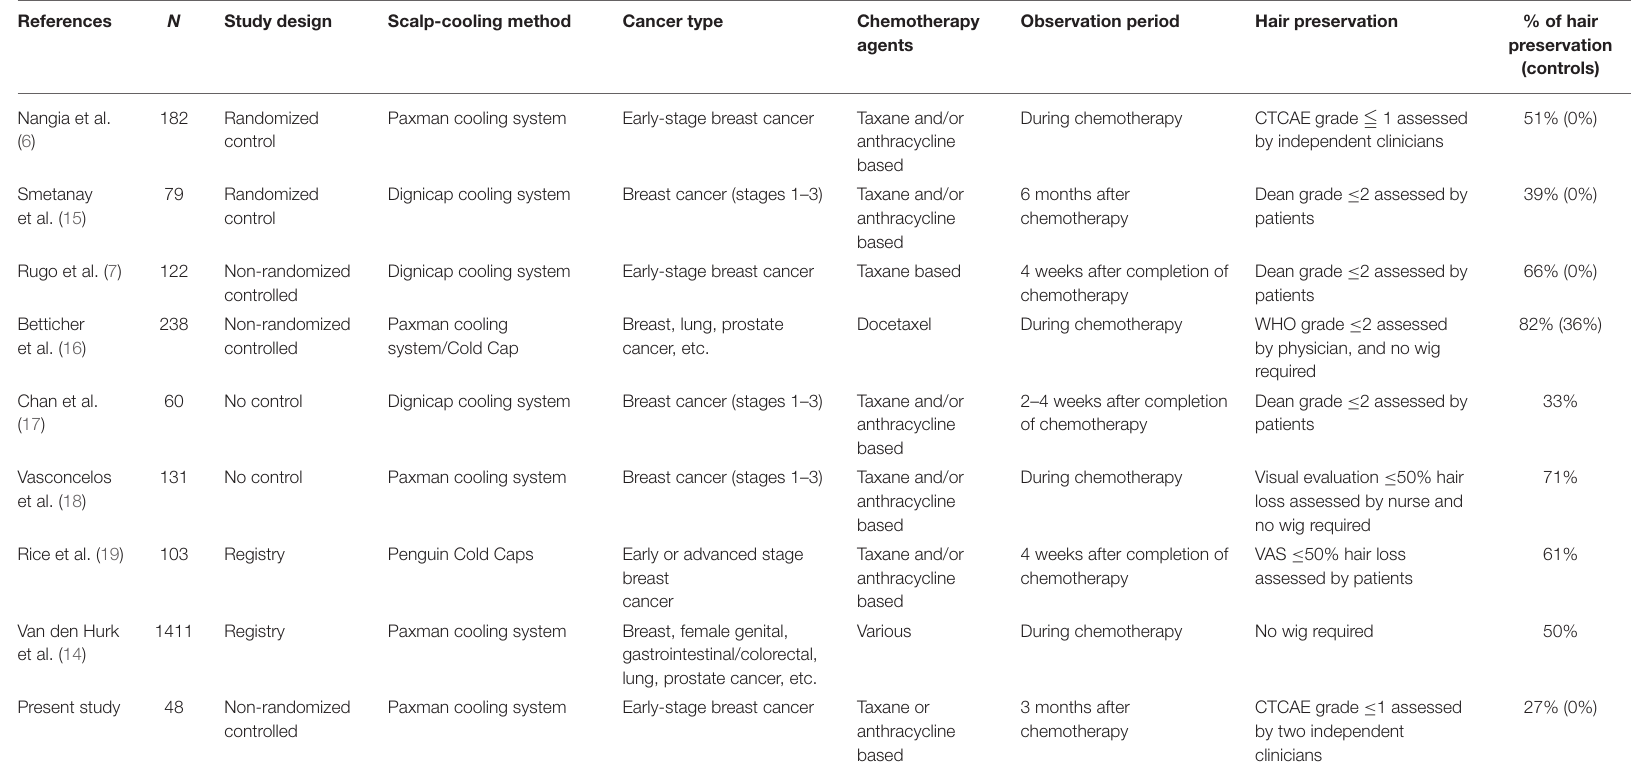
TABLE 5 | Results of recent scalp-cooling